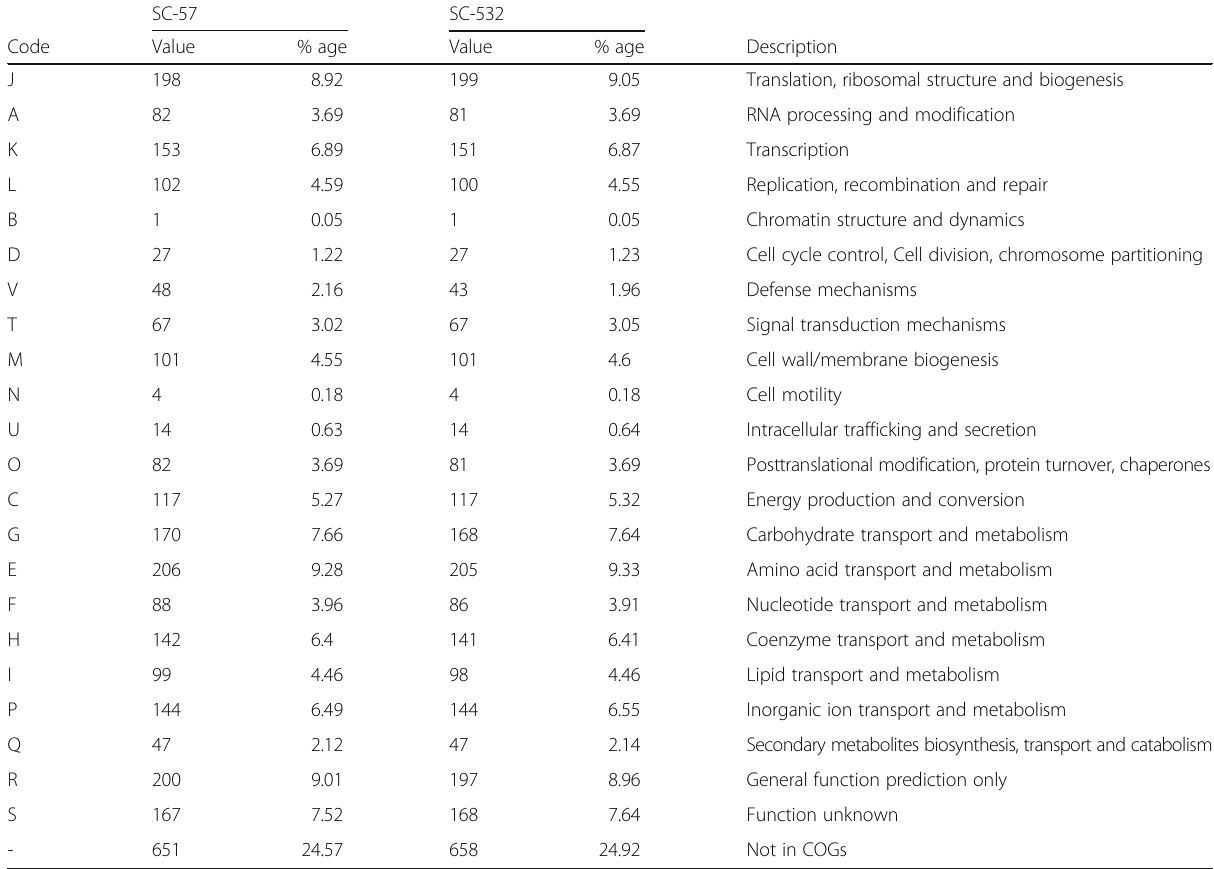
Table 4 Number of genes associated with general COG functional